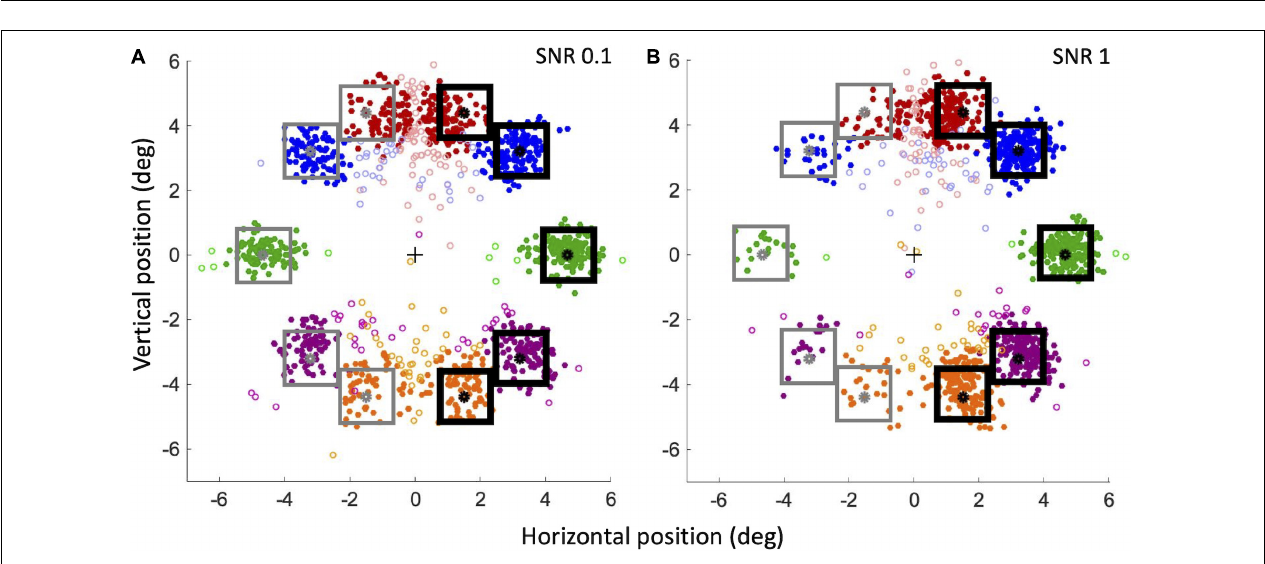
FIGURE 10 | Landing positions of correct and erroneous saccades for SNR 0.1 (A) and SNR 1 (B) . For our convention, the center of the screen corresponds to a horizontal component of 0; the target compound (black squares) is always on the right hemifield, and the distractor compound is always on the left hemifield (gray squares). Filled circles: valid saccades (within 1.5 ◦ ); empty circles: invalid saccades. Red circles: angle + 70 ◦ ; blue circles: angle + 45 ◦ ; green circles: angle 0 ◦ ; violet circles: angle –45 ◦ ; orange circles: angle –70 ◦